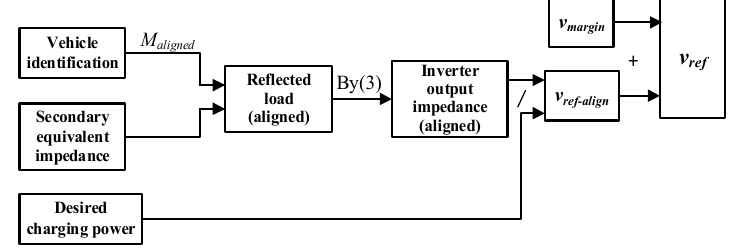
Figure 10. Data transfer and calculation process.